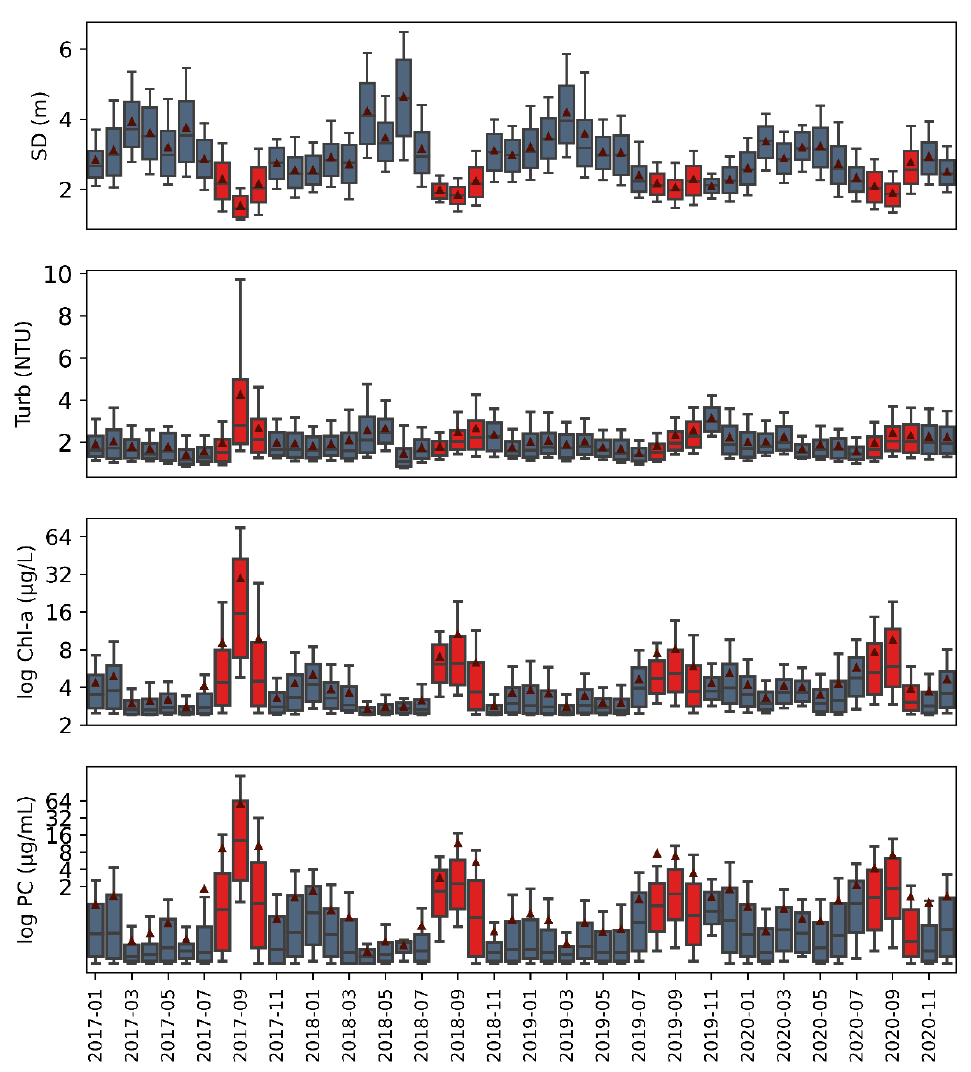
Figure 8. Boxplots with the monthly evolution of Chl-a, PC, SD, and Turb in the 2017–2020 period. The sample median is indicated by a horizontal line within the box while the triangle represents the monthly average.